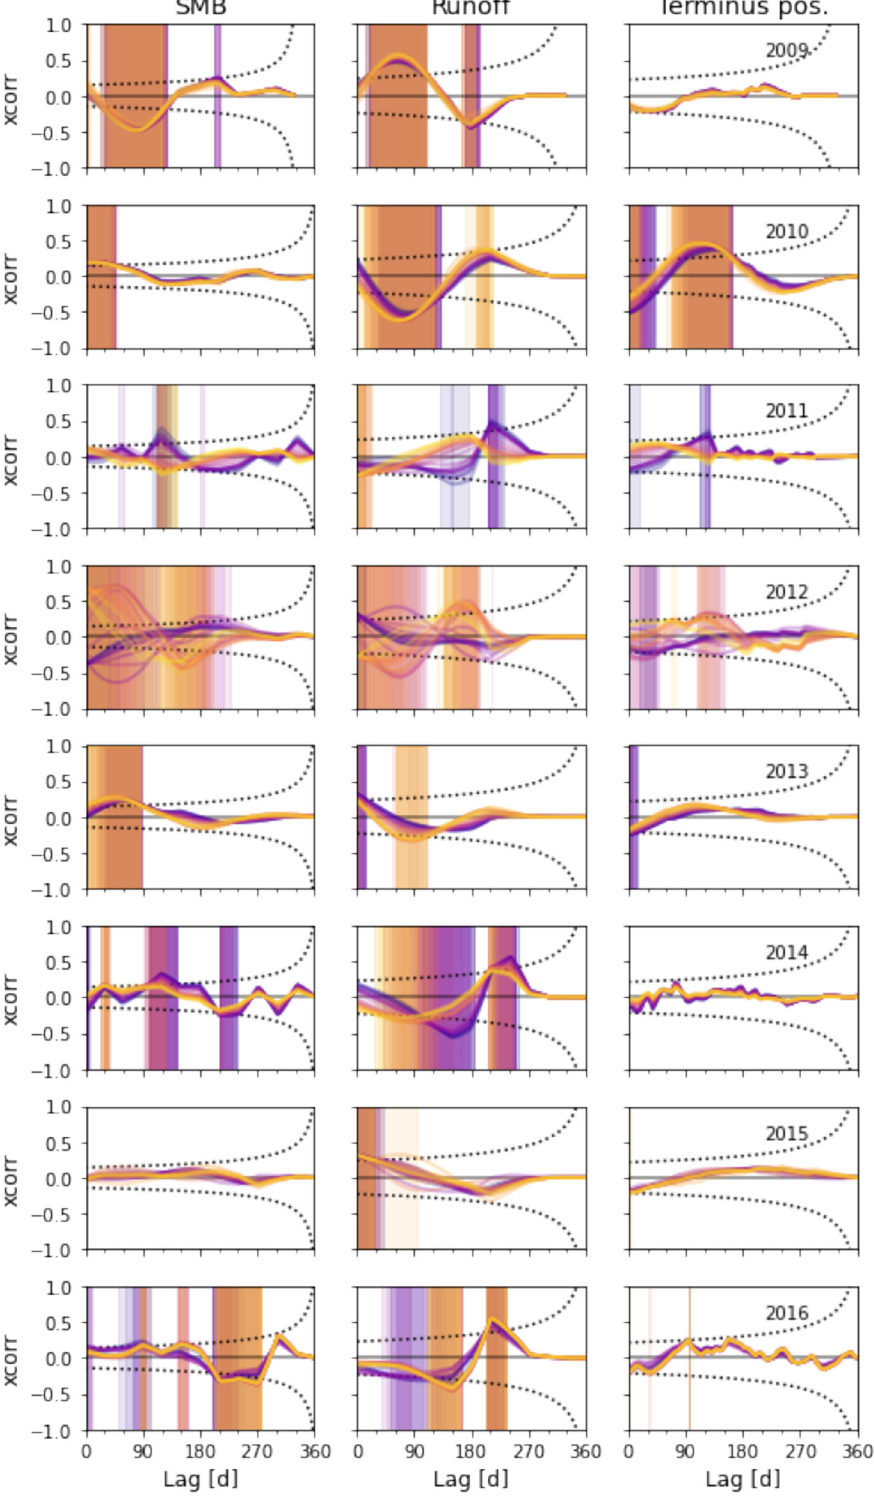
Fig.3|Annualpatternsofcross-correlationbetweensurfacespeedandsystem variables for (left) surface mass balance, (center) runoff, and (right) terminus position, sampled at 1km intervals along the fl owline shown in Fig. 1. Dotted curves indicate 95% con fi dence intervals around XCorr( f , v )=0, modi fi ed for